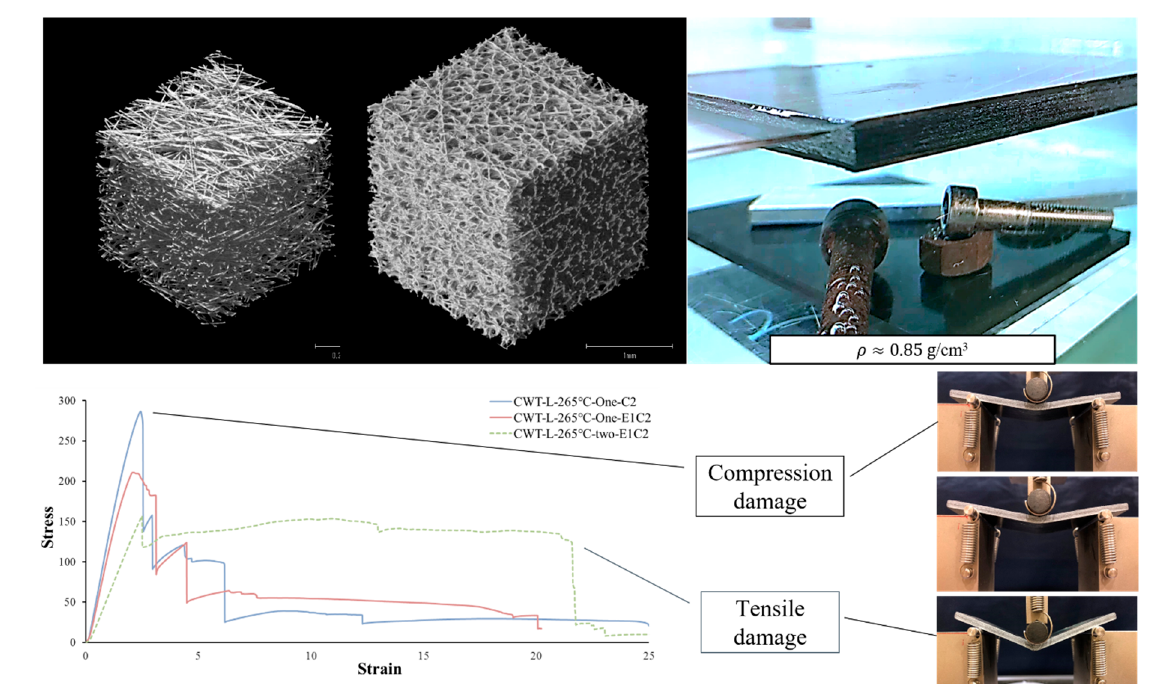
Figure 15. Spring-back effect and the toughened spring-back sandwich fabricated from CWTs.